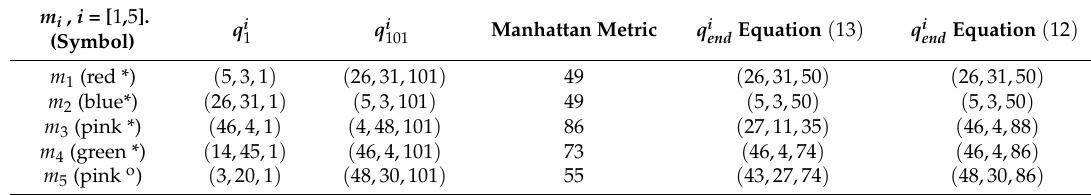
Table 6. Start, goal configurations, Manhattan metric and results of the five moving microparts.